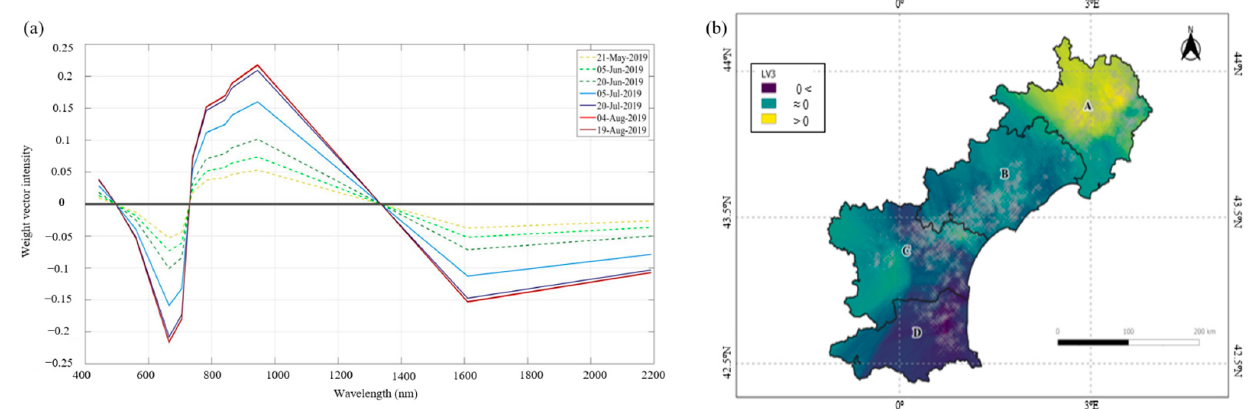
Figure 12. ( a ) Representation of LV3 weight vectors from N-PLS applied to the calibration set (75% of the 107 vineyard blocks) for each date; ( b ) kriged map of the LV3 score values for blocks at the regional scale. The most negative score values of the blocks on LV3 ( b ) are shown in blue, and the most positive score values in yellow.